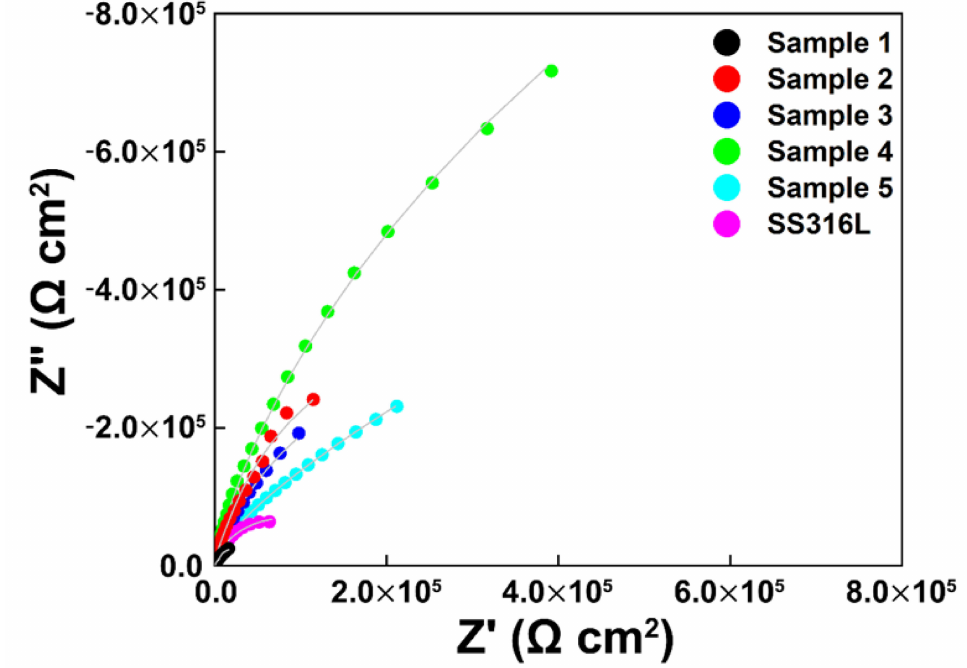
Figure 5. EIS measurements and analysis of coatings. Representative Nyquist plots of uncoated SS316L and coated samples at their respective E OCP in a 0.5 M H 2 SO 4 + 2 ppm HF solution at 70 ◦